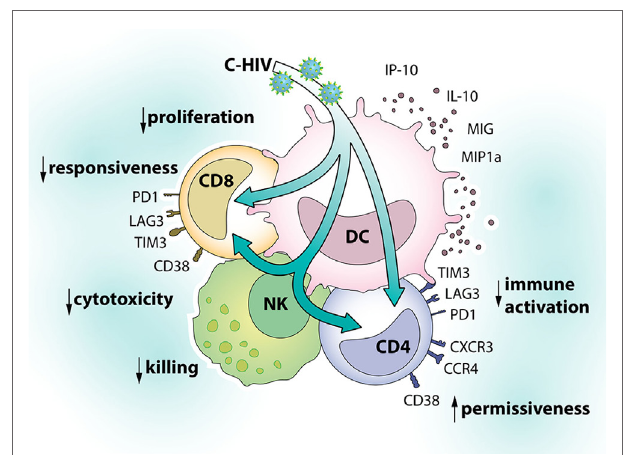
FigUre 9 | Effects of complement-opsonized HIV (C-HIV) on dendritic cells (DCs), natural killer (NK) cells, and T cell phenotype. Complement fragments on HIV’s surface modulate responses in DCs and their cross talk with NK cells to inhibit killing and promote the upregulation of factors associated with immune suppression (PD-1, TIM-3, LAG-3) and susceptibility to infection (CD38, CXCR3, CCR4) on T